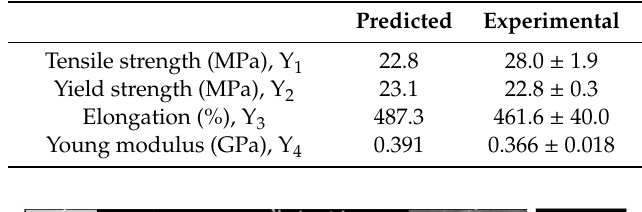
Table4. ComparisonbetweenpredictedandexperimentalvaluesofUHMWPE / CNFbionanocomposites fabricated at optimal conditions.